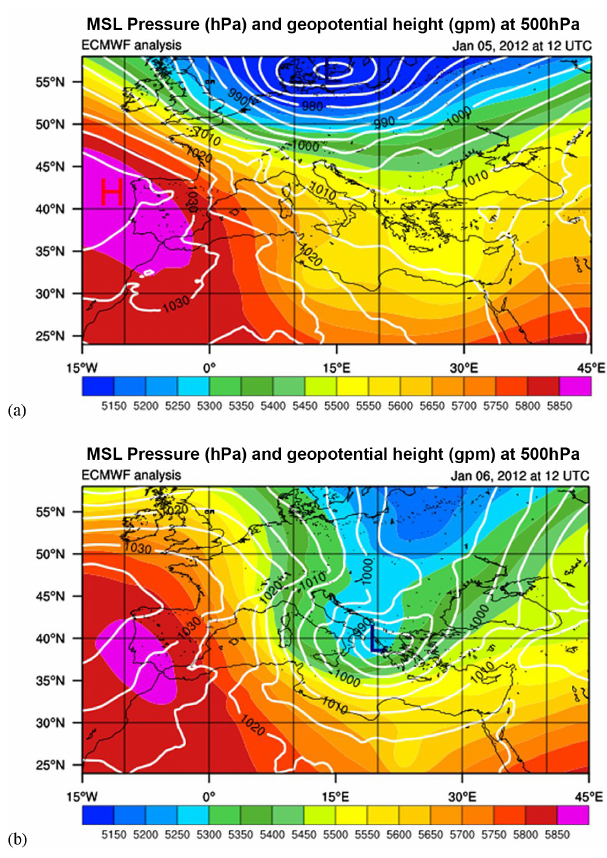
Figure 9. Mean sea level pressure (contours in hPa) and geopoten- tial height at 500hPa (colored shaded in gpm) for (a) 5 January at 12:00UTC, and (b) 6 January at 12:00UTC 2012. Data are based on ECMWF operational analysis.